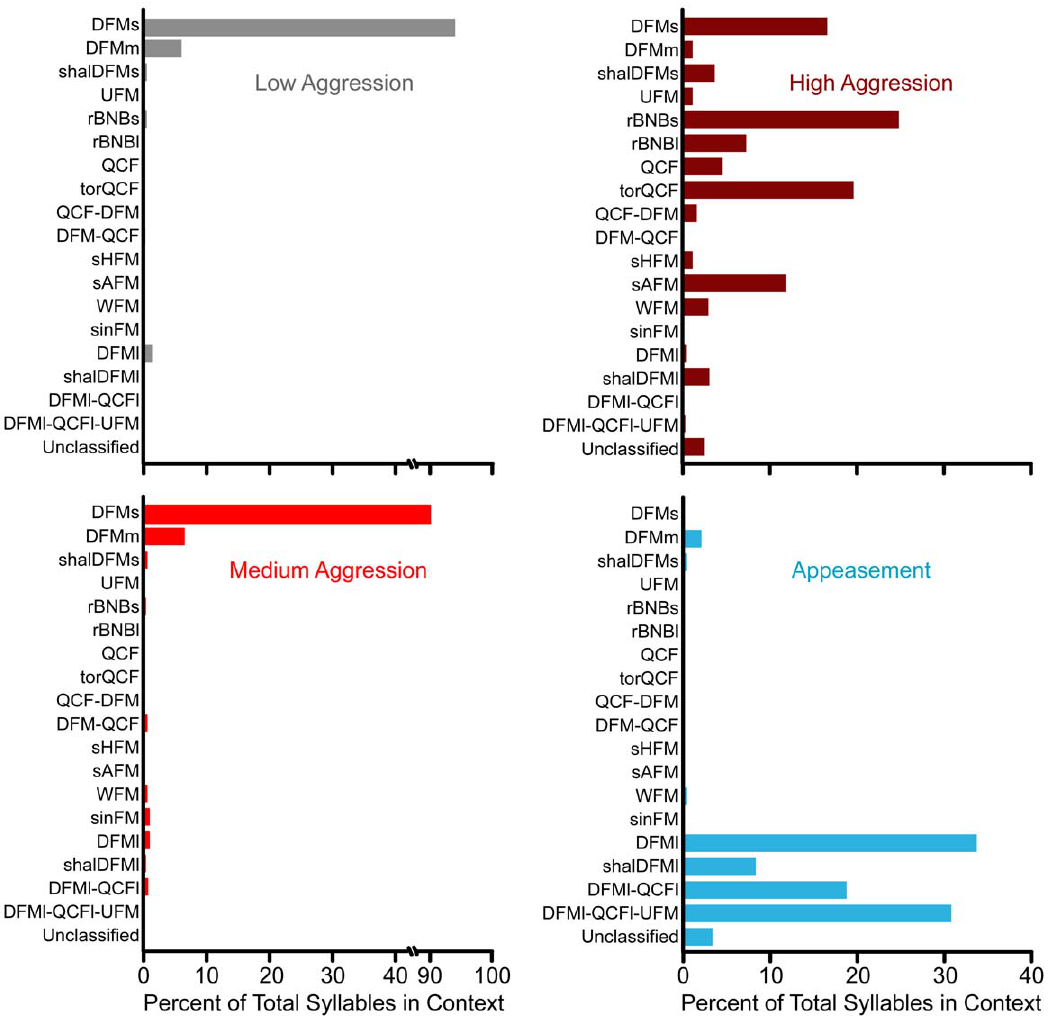
Figure 3. Probability of syllable types emitted across four behavioral contexts. The DFMs syllable type was the predominant syllable in both low aggression ( grey ) and medium aggression ( light red ) contexts. Syllable diversity increased during high aggression ( dark red ), with rBNBs being the most common syllable type. Four appeasement syllables were commonly emitted during appeasement ( blue ). Note the broken horizontal axis for low and medium